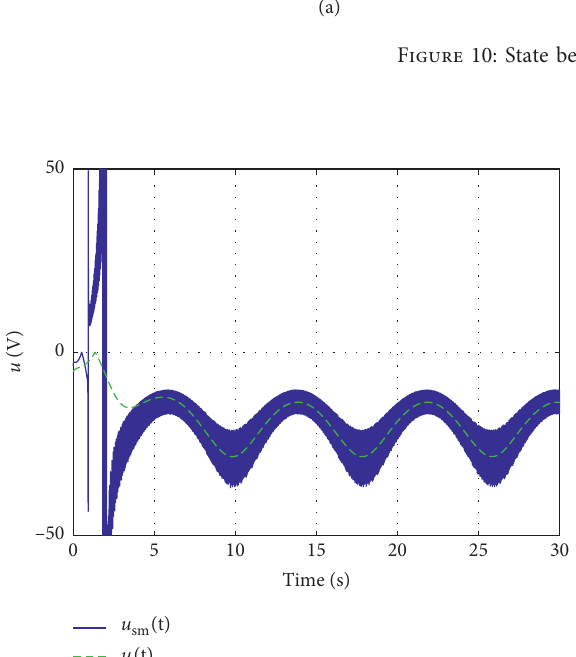
Figure 11: Control input (comparison test).